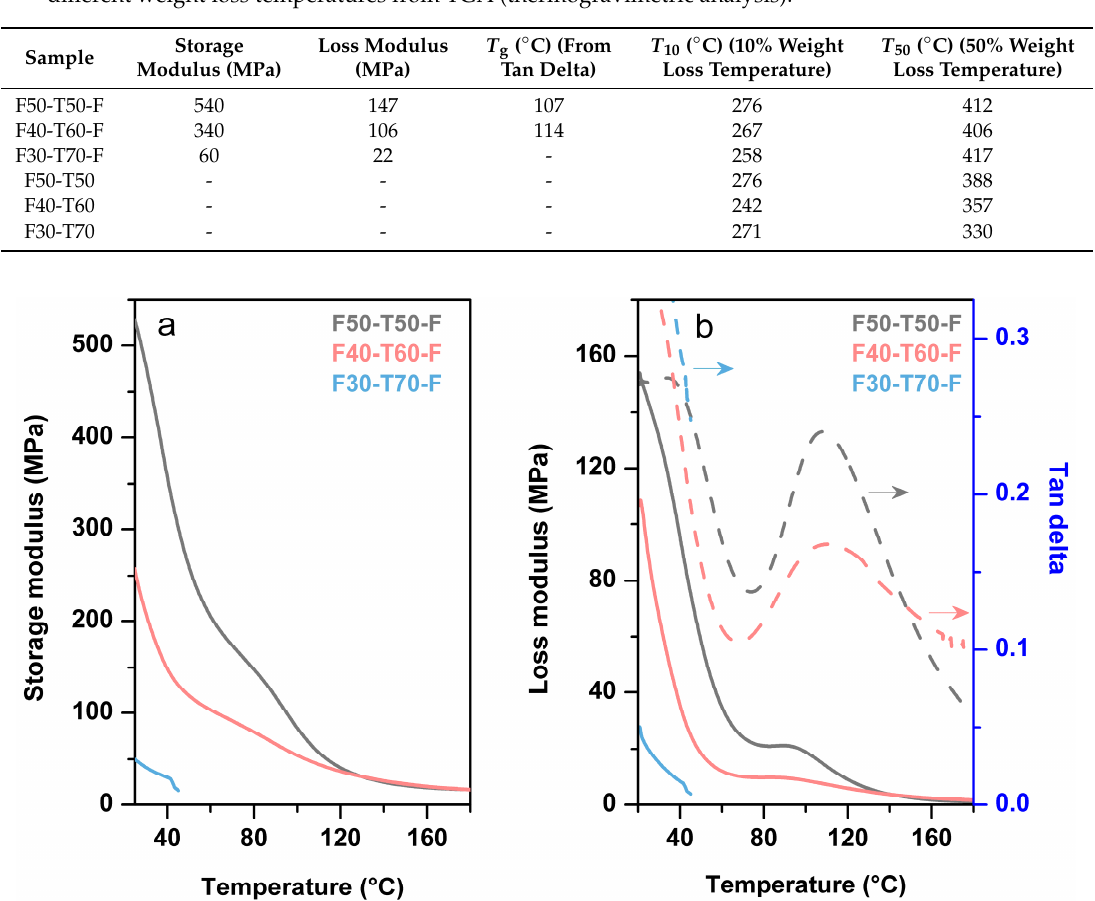
Figure 7. DMA (dynamic mechanical analysis) plots (( a ) storage modulus and ( b ) loss modulus and tan delta) of film samples F50-T50-F, F40-T60-F and F30-T70-F (In Figure 7b, arrows indicate the tan delta axis).